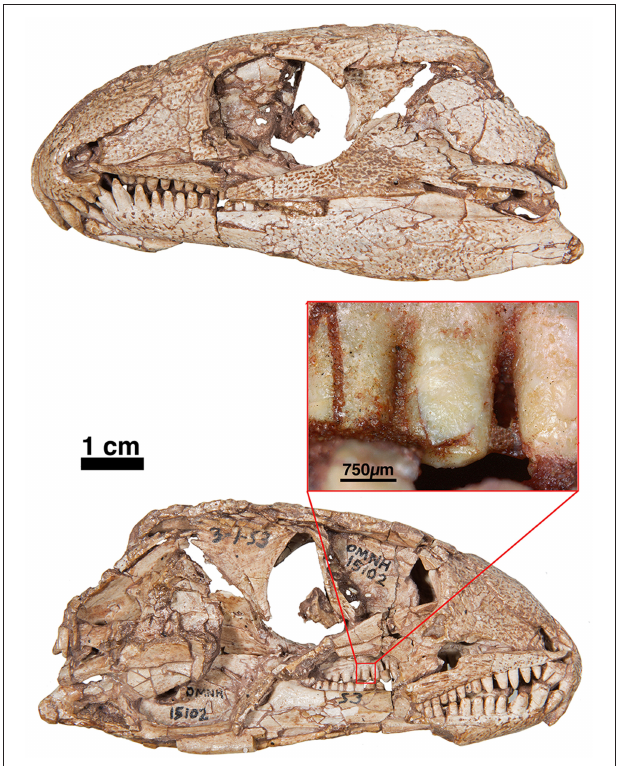
FIGURE 5 | FMNH-UC642. Holotype of Captorhinus laticeps in dorsal (Left) and ventral (Right) views. This specimen contains the skull and post-cranial elements, including shoulder and pelvic girdles. Over the last century additional preparation has resulted in significant damage to most of the exposed surface.